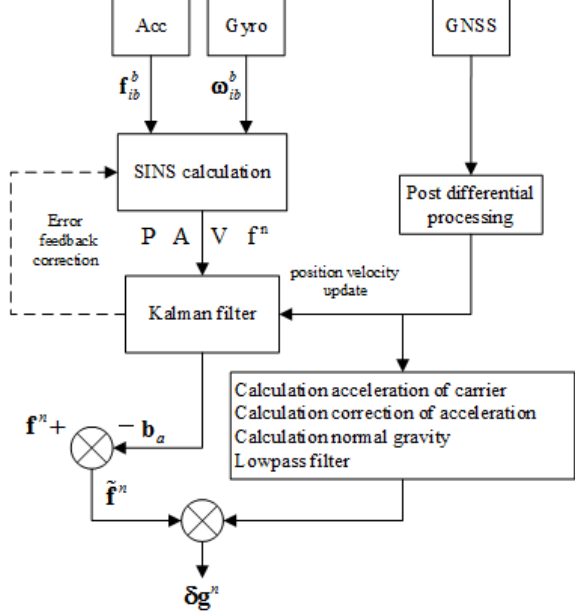
Figure 2. Strapdown airborne gravimeter data processing block